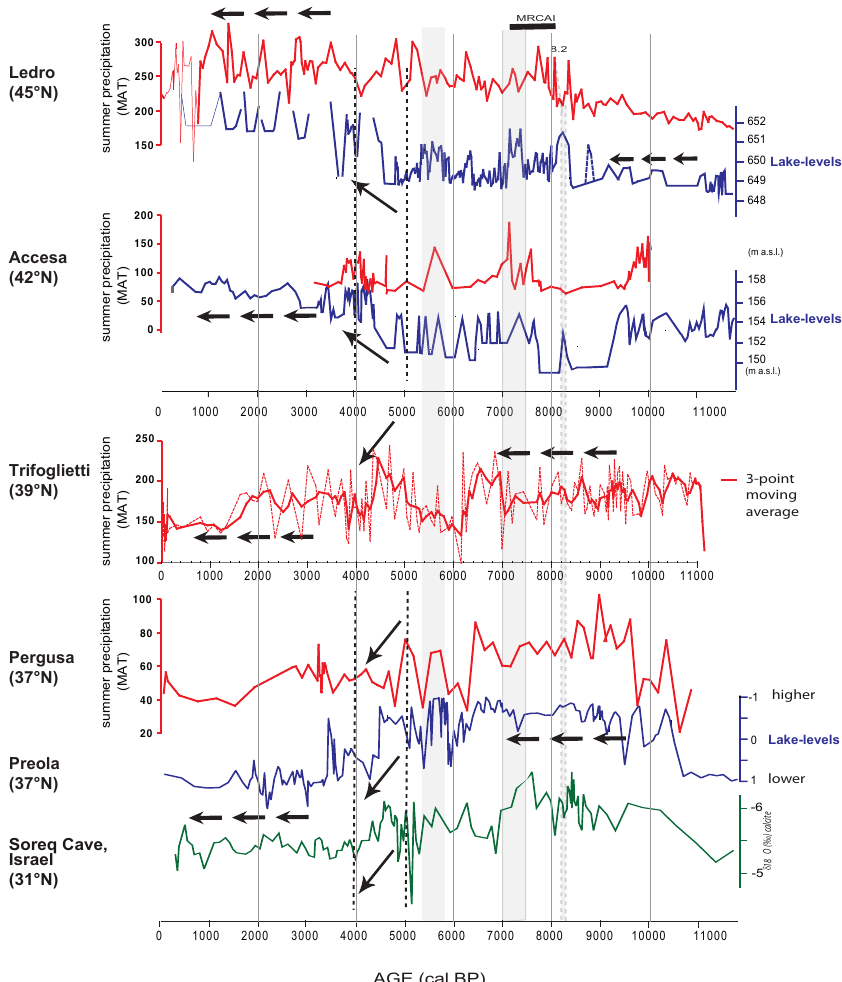
Fig. 6. Comparison between pollen-inferred summer precipitation (MAT only) and lake-level variations at Lakes Ledro, Accesa, Trifoglietti and Pergusa. More details on the lake-level data are given in Magny et al. (2012a) for Lake Ledro, Magny et al. (2007) for Lake Accesa, and Magny et al. (2011) for Lake Preola (Sicily). Oxygen isotope data based on speleothem from Soreq Cave, Israel, is also plotted for comparison with eastern Mediterranean sites (Bar-Matthews and Ayalon, 2011; Bar-Matthews et al., 1998; Vaks et al., 2006). MRCAI=period of maximal rate of change in annual